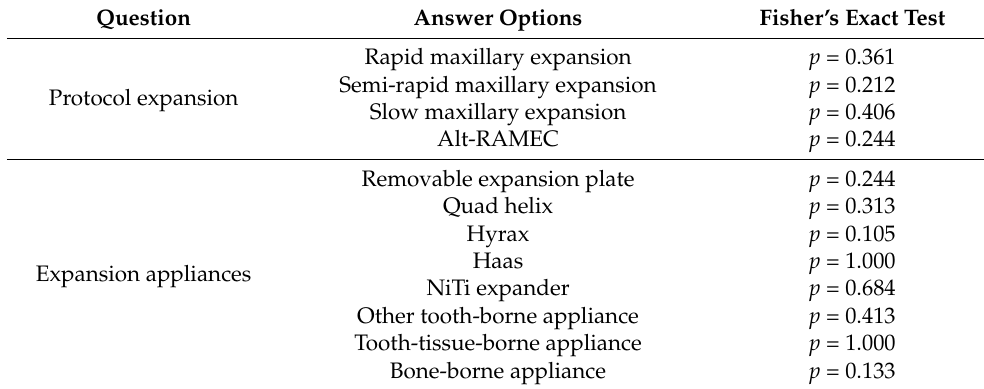
Table 2. Correlation between CLP practice time and the protocol or type of orthodontic